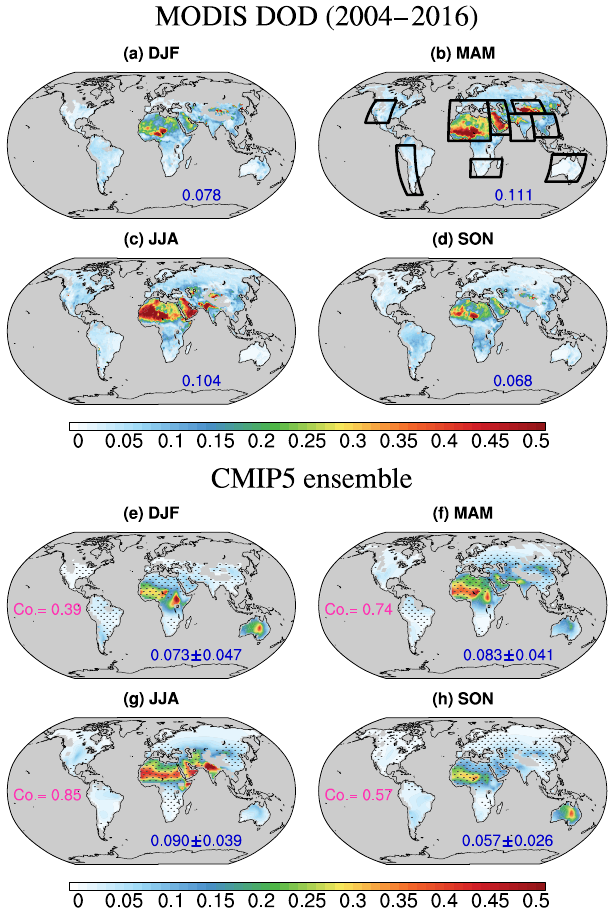
Figure 1. Climatology (2004–2016) of Aqua and Terra combined DOD (i.e., MODIS DOD; a–d ) and multi-model mean of CMIP5 DOD ( e–h ) for four seasons. The pattern correlations (centered; calculated after interpolating MODIS DOD to CMIP5 DOD grids) between CMIP5 and MODIS DOD are shown in pink in the bot- tom panel. Blue numbers denote global mean DOD over land. For CMIP5 model results, ± 1 standard deviation among seven CMIP5 models is also shown. Black boxes in (b) denote nine averaging re- gions (Table 2). Here we only added these boxes in (b) instead of every plot to keep the figure clean. Note that CMIP5 multi-model mean is masked by MODIS DOD for comparison. The dotted area in (e–h) shows where multi-model mean is greater than 1 inter- model standard